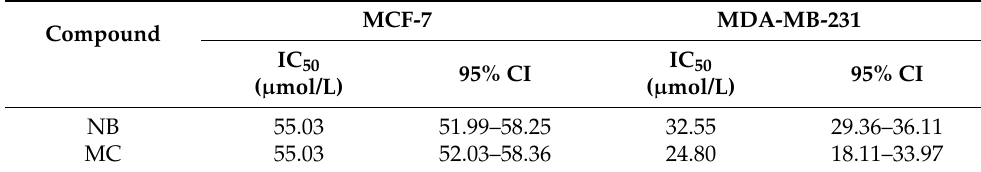
Figure 7. MTT growth assays in MCF-7 and MDA-MB-231 cells treated or not treated with increasing doses (1, 10, 50, 70, 100, 150 µM) of MNA and with 1 µM of either TAM or DOXO, respectively, for 24 and 48 h. Cell proliferation is expressed as fold change ± S.D. relative to vehicle-treated cells and is representative of three different experiments each performed in triplicate. Statistical significance was considered at * p ≤ 0.05; ** p ≤ 0.01. Statistical comparison was drawn between groups using a two-sample two-tailed t -test. C = control. Table 2. IC 50 of NB and MC for MCF-7 and MDA-MB-231 cell lines. IC 50 is defined as the drug concentration causing a 50% decrease in cell population after 24 h culture. CI = confidence interval.